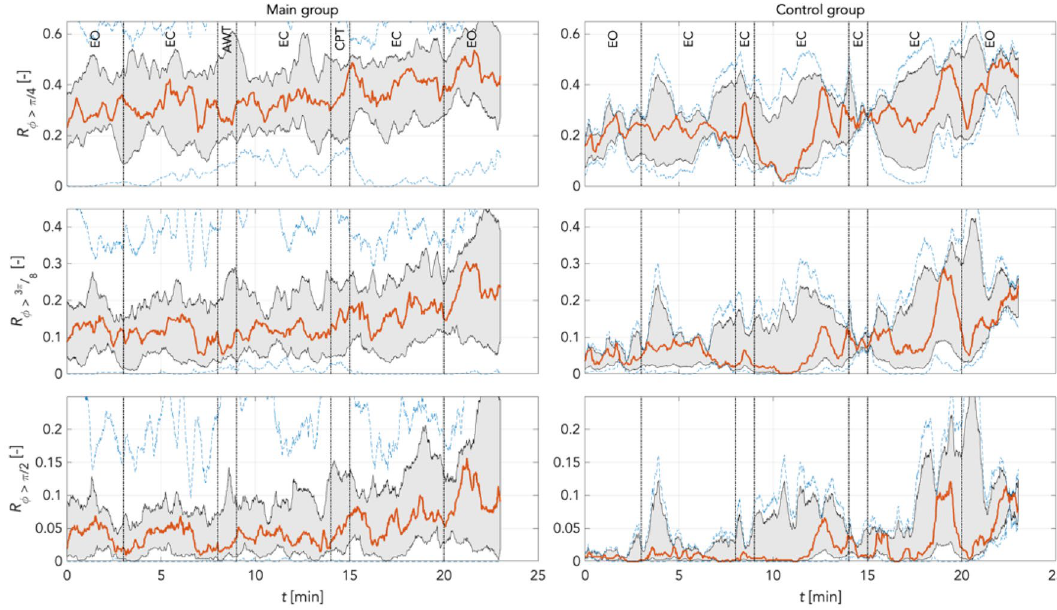
Figure 13. Phase desynchronization for different thresholds for main and control groups in the IM_Pf band (0.1 Hz – 0.15 Hz) including 0.1 Hz activity. There were only few oscillations in the main group. The increases in phase desynchronization due to CPT were of magnitudes comparable to other non-experimental oscillations. In controls, few prominent spontaneous oscillations. In both groups, phase desynchronization increased over time. Levels of phase desynchronization were π/4 > 3π/8 > π/2 rad in both groups. Red: median curve, black vertical lines: stages of the experiment, grey area bounds: 25 th and 75 th percentiles; blue dashed lines: min and max values.